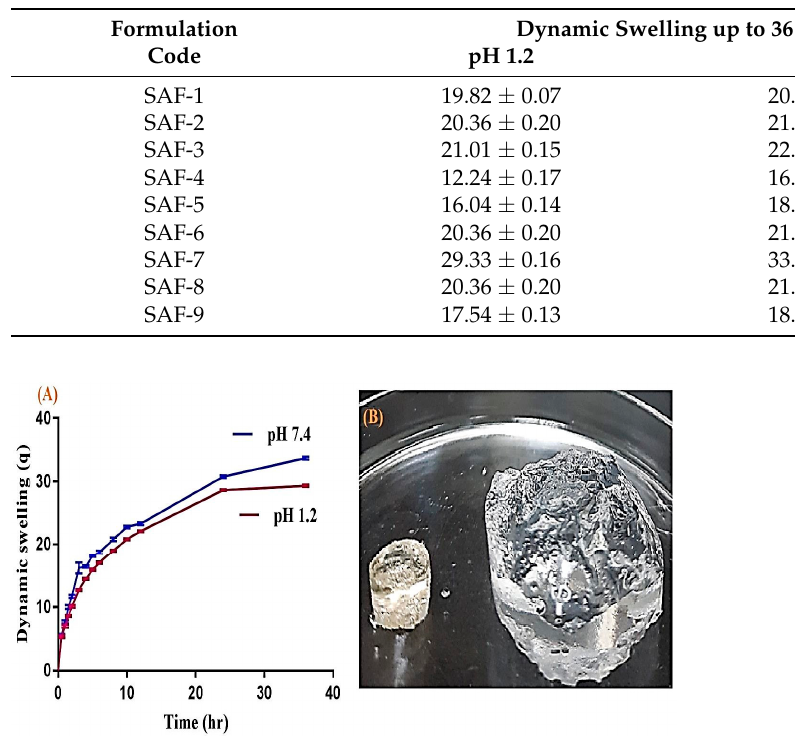
Table 2. Dynamic swelling of SA-co-poly(AMPS) hydrogel.